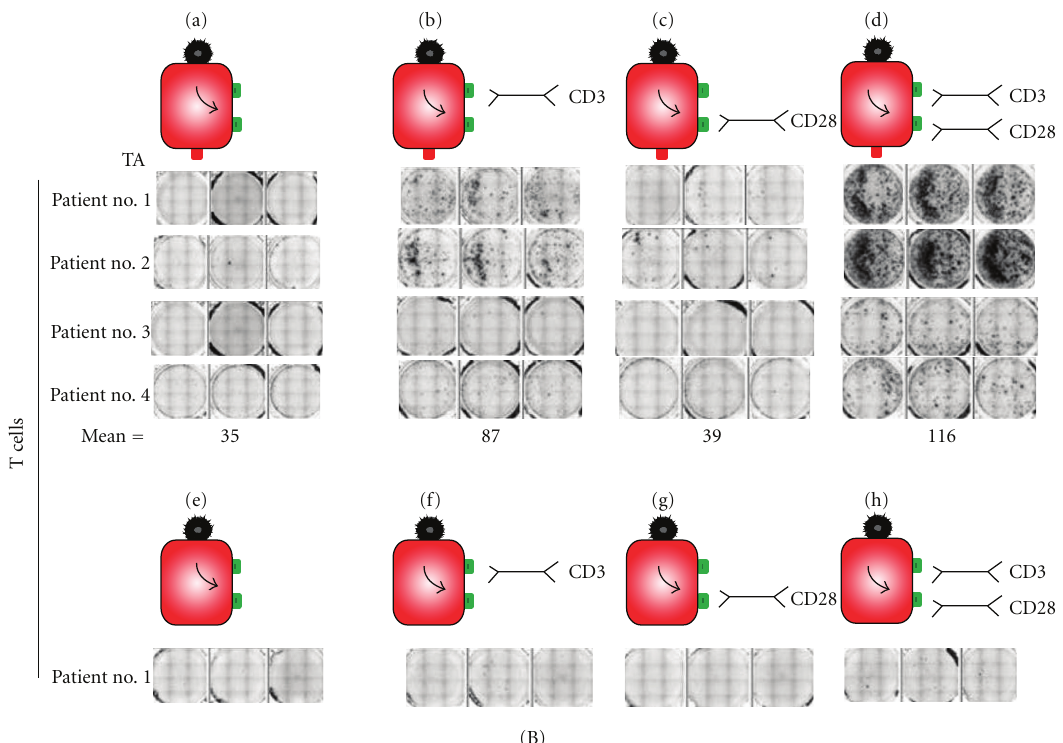
Figure 2: Reactivation of tumor-reactive memory T cells of cancer patients (here HNO cancer patients) by the ATV-NDV tumor vaccine of the 2nd generation. (A) Protocol for the ex vivo stimulation of T cells from cancer patients by the NDV-based tumor vaccine of the second generation in an autologous setting. Purified T cells isolated from tumor-draining lymph nodes (LN) of HNSCC patients were tested for their capacity to be restimulated and to produce IFN- γ upon contact with various combination of the ATV-NDV tumor vaccine (generated from the autologous tumor) and bsAbs molecules. For that, they were coincubated for 40 hours with the indicated autologous vaccine formulations(tumor) ( n = 4). For specificity control, the unrelated human promonocytic tumor cell line U937 (U937) was modified identically and used to reactivate the patients’ T cells. (B) IFN- γ ELISPOT results from A. Mean: mean number from triplicates of 4 patients spot forming T cells per 1 million cells. Each patient’s T cells were stimulated with four di ff erent formulations of either autologous (a–d) or heterologous (e–h) vaccine. T cells of patients no. 2, no. 3, and no. 4 also did not react to the heterologous vaccine (data not shown) (adapted from